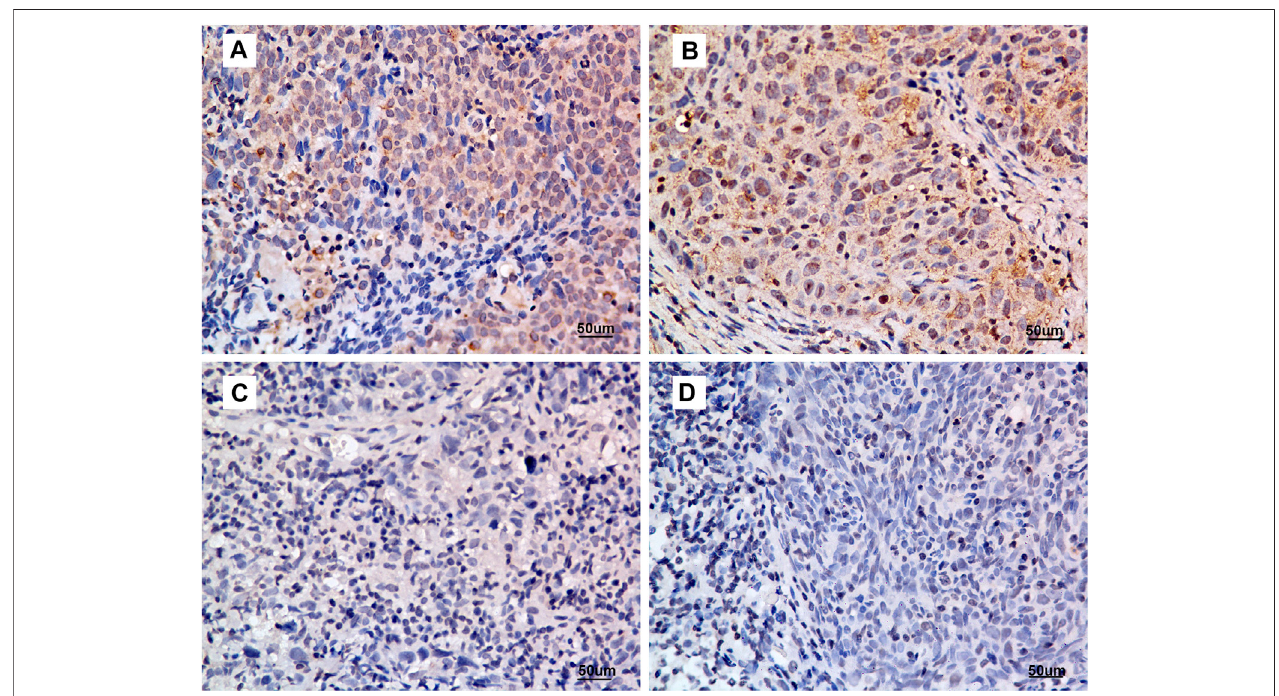
FIGURE 2 | Criteria for ANG expression intensity scoring. (A) intensity score (cid:2) 3, (B) intensity score (cid:2) 2, (C) intensity score (cid:2) 1, and (D) intensity score (cid:2) 0. Representative micrographs are shown (400 × ). All micrographs were collected and processed under identical conditions.